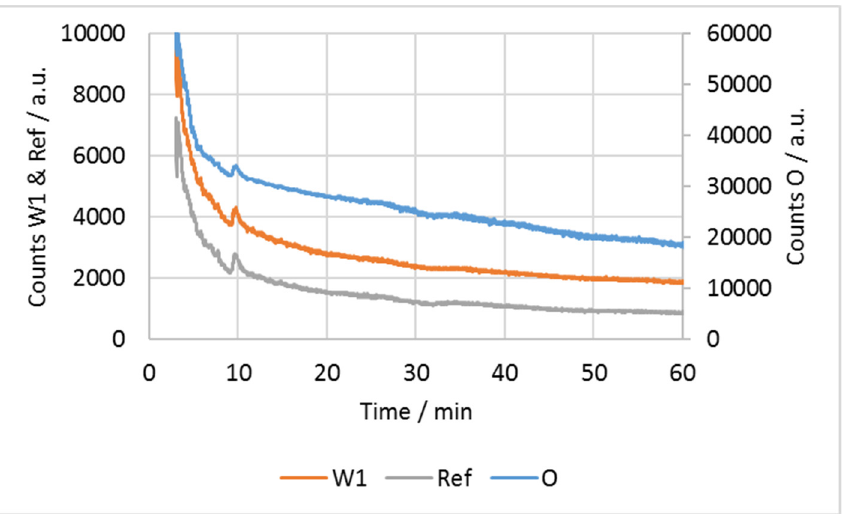
Figure 5. Courses of the three photometric channels during an exemplary measurement. The inner phase contained 49% ammonium nitrate, the outer phase 10% ammonium chloride. A second y-axis was implemented for the oil phase to make it easier to visually compare the data sets. W1: signal of ammonium nitrate in inner water phase, Ref: signal of the reference, O: signal of the oil phase.